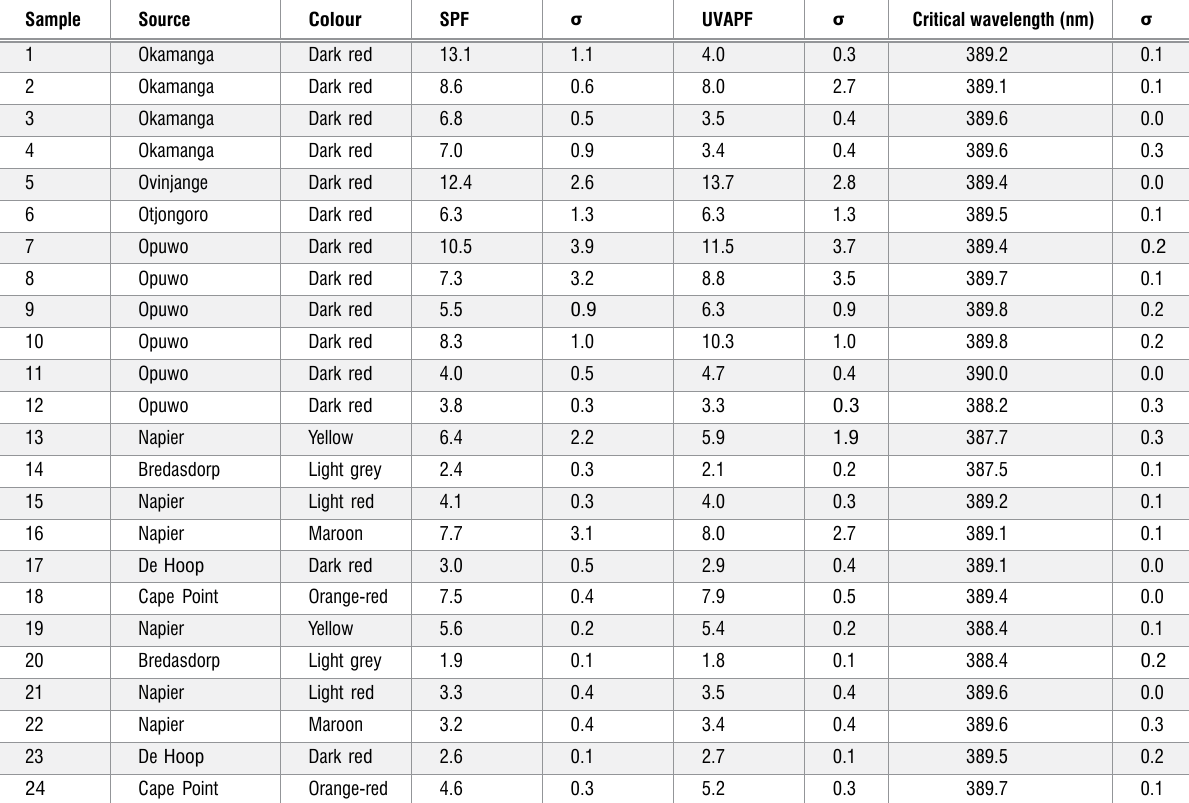
Sun protection factor (SPF) values of ethnographic and experimental ochre powder samples obtained by in vitro